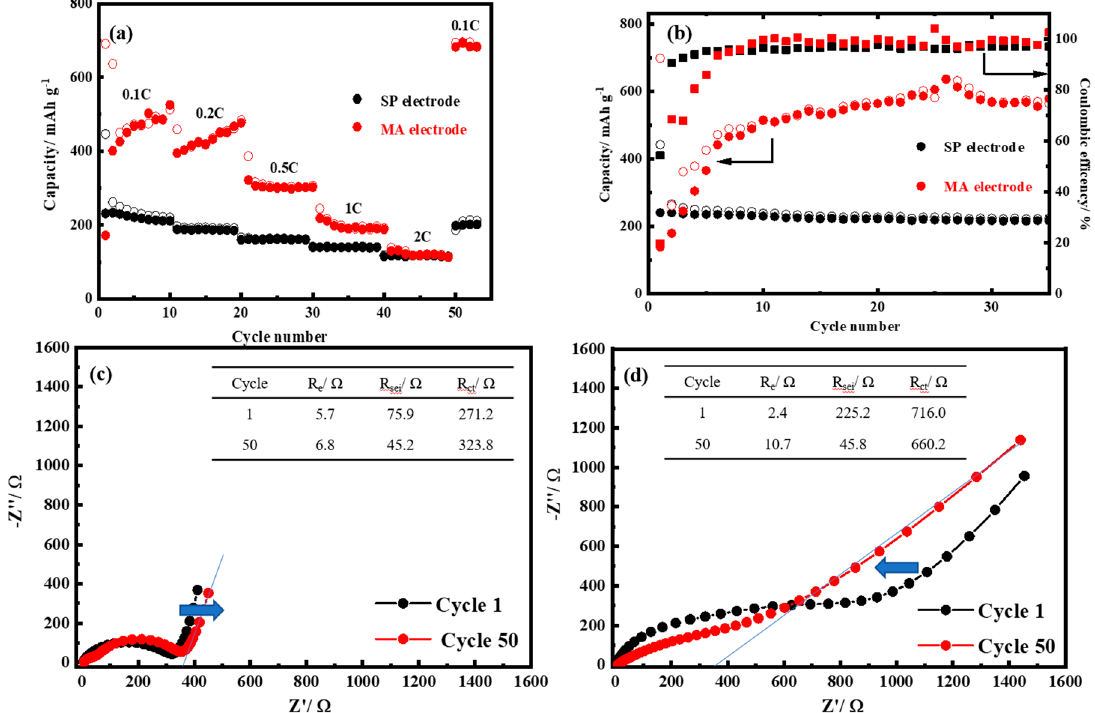
Figure 3. ( a ) The rate capability and ( b ) the cyclability of the SP and the MA electrodes. The electrochemical impedance spectroscopy (EIS) measurements of ( c ) the SP and ( d ) the MA electrodes at the first and the 50th cycle.